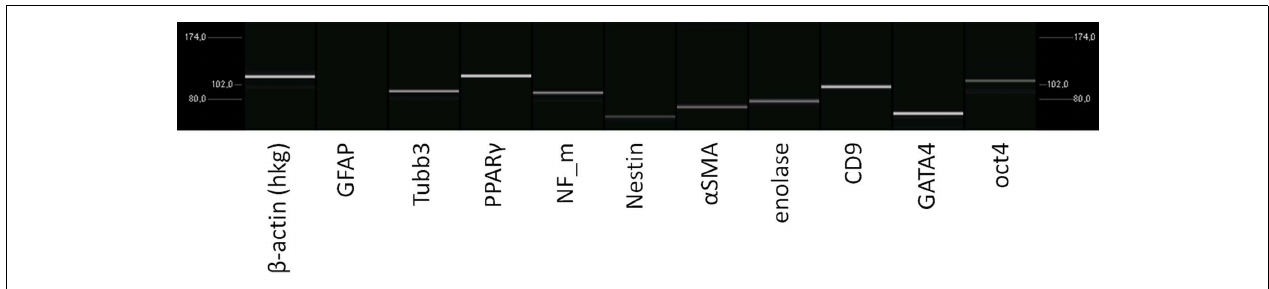
FIGURE 7 |Analysis of the transcriptome of rat pancreatic stem cells grown on polyimide˚2 film covered with fibrin. The considered markers are assigned below.